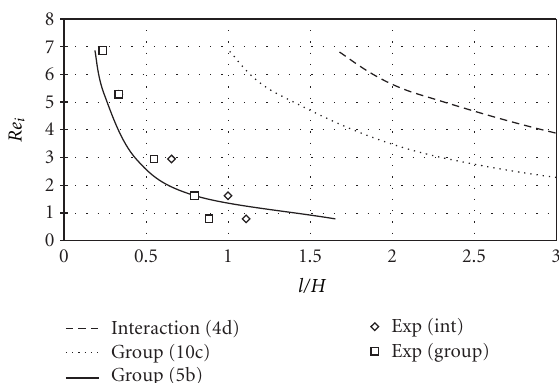
Figure 18: Comparison of theoretical predictions (given in (4d), (5b), and (10c)) and experimentally observed interburner spacing nondimensionalized by the visible flame height of a single isolated jet for CH 4